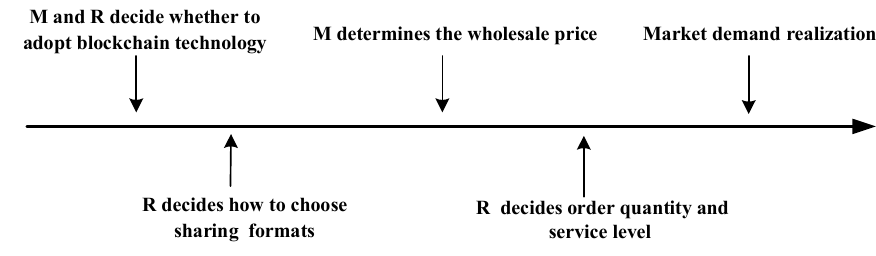
Figure 2. Sequence of events.